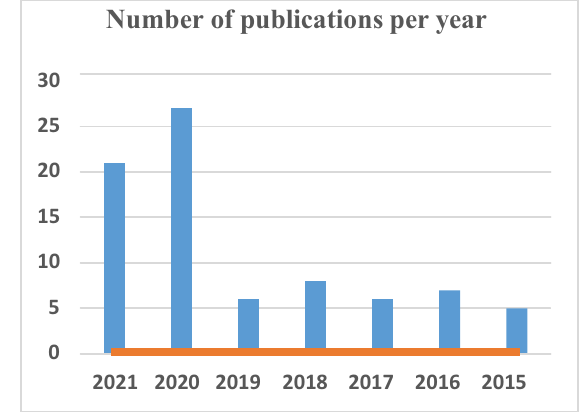
Fig 3. Number of publications per year